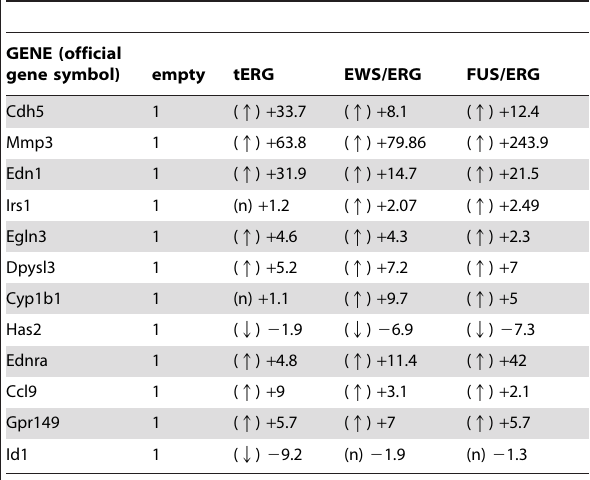
Table 1. Validation of gene expression deregulation through quantitative Real-Time PCR in NIH-3T3 transfectants.